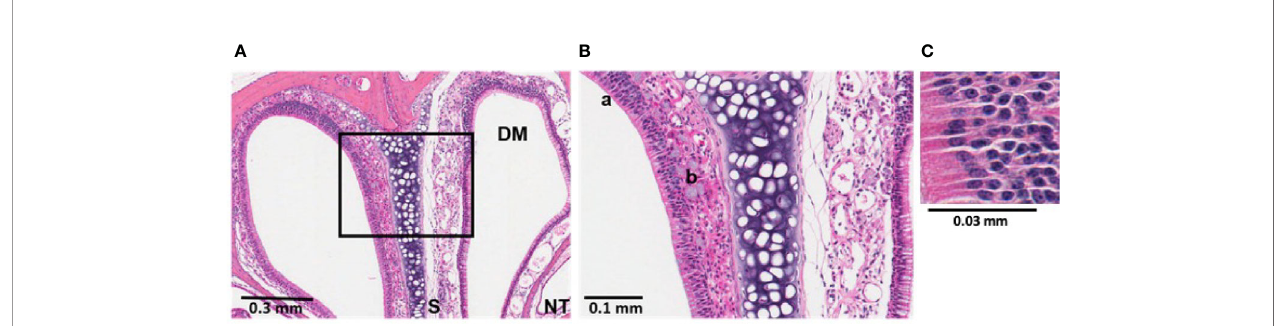
FIGURE 2 | Bacterial induction of in fl ammation in sinonasal mucosa was partially mediated by neutrophils. Histological sections treated with hematoxylin and eosin (H&E) stain revealed sinonasal mucosa with neutrophilic in fl ammation that was most pronounced at 24 h post-infection. P. aeruginosa LESB58 was inoculated dropwise in the left naris of C57Bl/6 mice (~10 6 CFU) providing a within-subject control in the right naris. (A) Focal neutrophil in fi ltration (30-40x more neutrophils per high power fi eld) was observed at a 4 mm deep cross-section of the nasal cavity. Sinus secretions (mucus) with admixed cells were most abundant at 24-h post- infection. (B, C) Select areas of the fi eld were expanded for visualization of a) neutrophilic in fl ammation and b) mucus secreting cells. Abbreviations used: DM, dorsal meatus; NT, nasoturbinate;